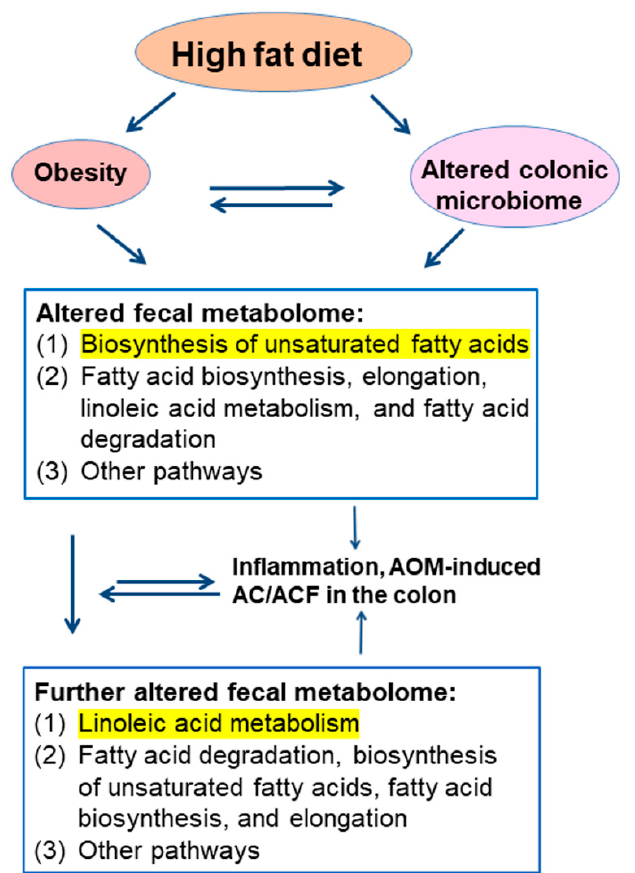
Figure 6. Proposed changes in top fecal metabolomic pathways in an AOM-induced colon cancer mouse model fed with a HFD. The most critical pathways are highlighted with yellow.